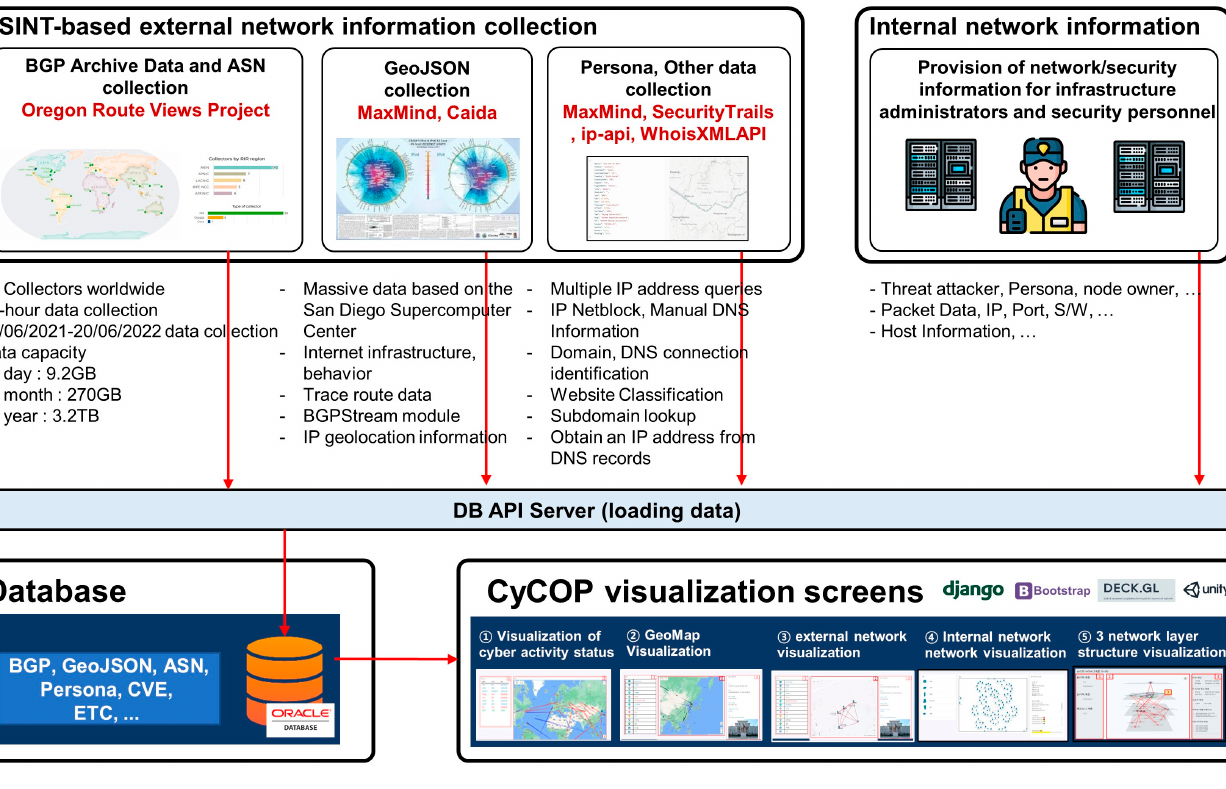
Figure 5. CyCOP Framework Structure.